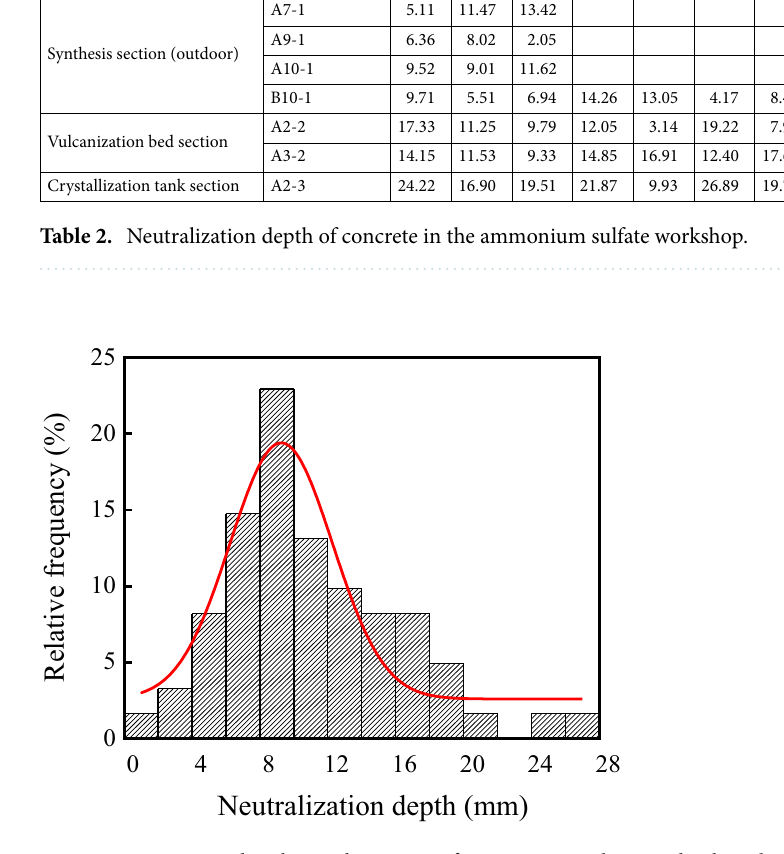
Figure 7. Frequency distribution histogram of concrete neutralization depth in the ammonium sulfate